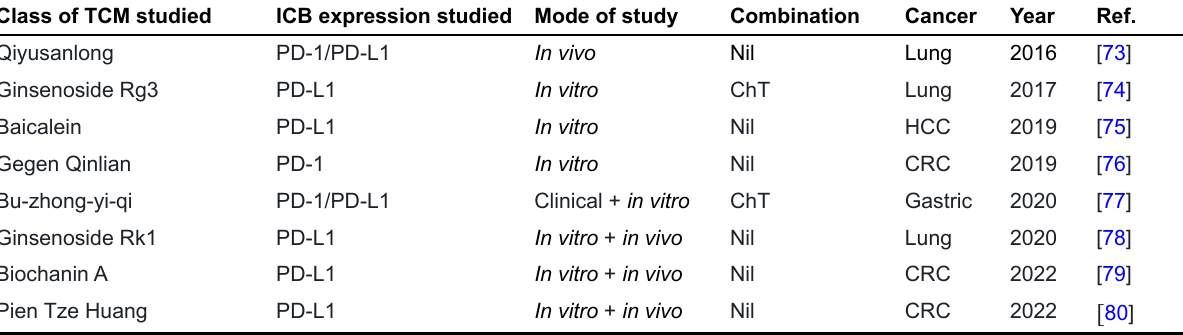
Table 3. Selected effects of TCMs on PD-1/PD-L1 linkage Class of TCM